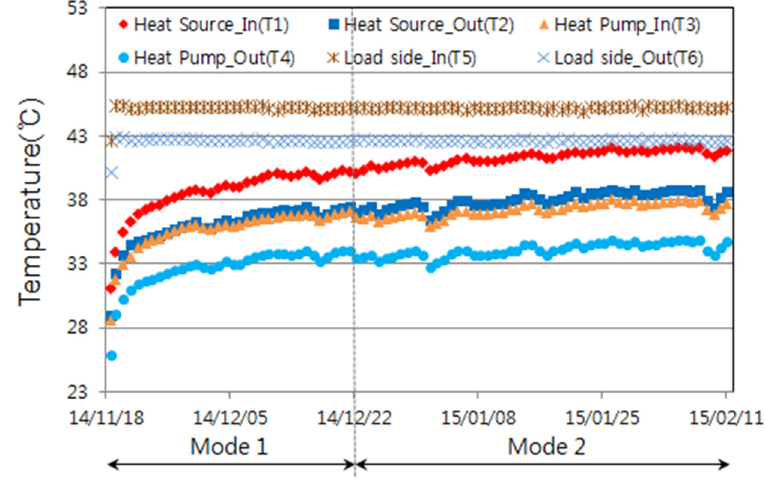
Figure 4. Temperature of experimental results.